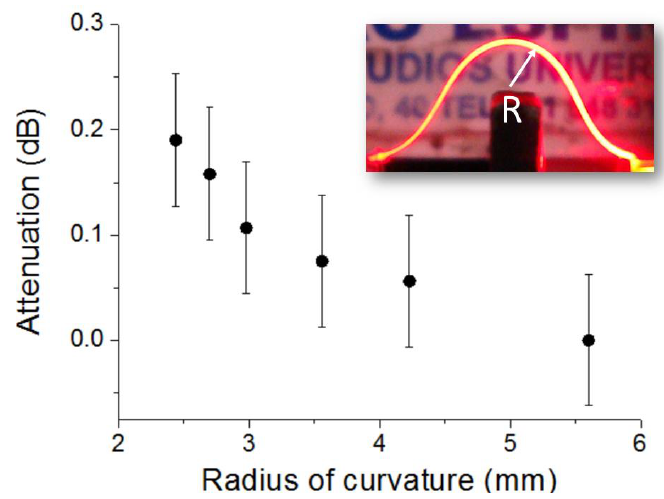
Figure 6. Measured optical attenuation introduced by bending a 24.7-mm-long tape waveguide at different radii of curvature (R). Inset shows a profile photograph of a bent tape waveguide guiding light, depicting the radius of curvature.